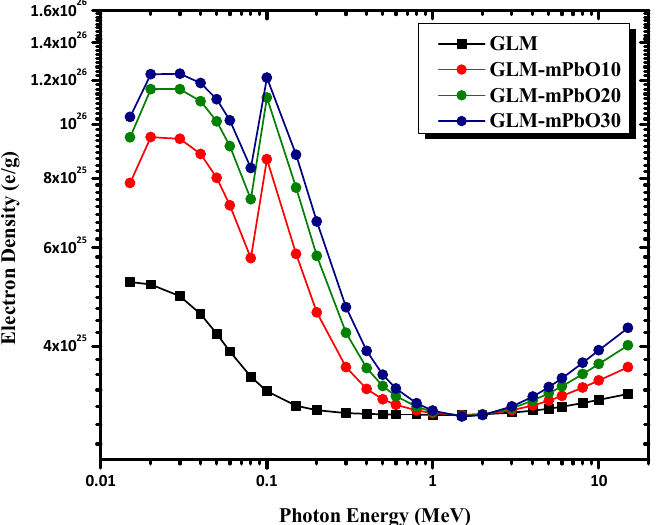
Figure 10. The Variation of the N el with incident gamma-ray energy of mortars.